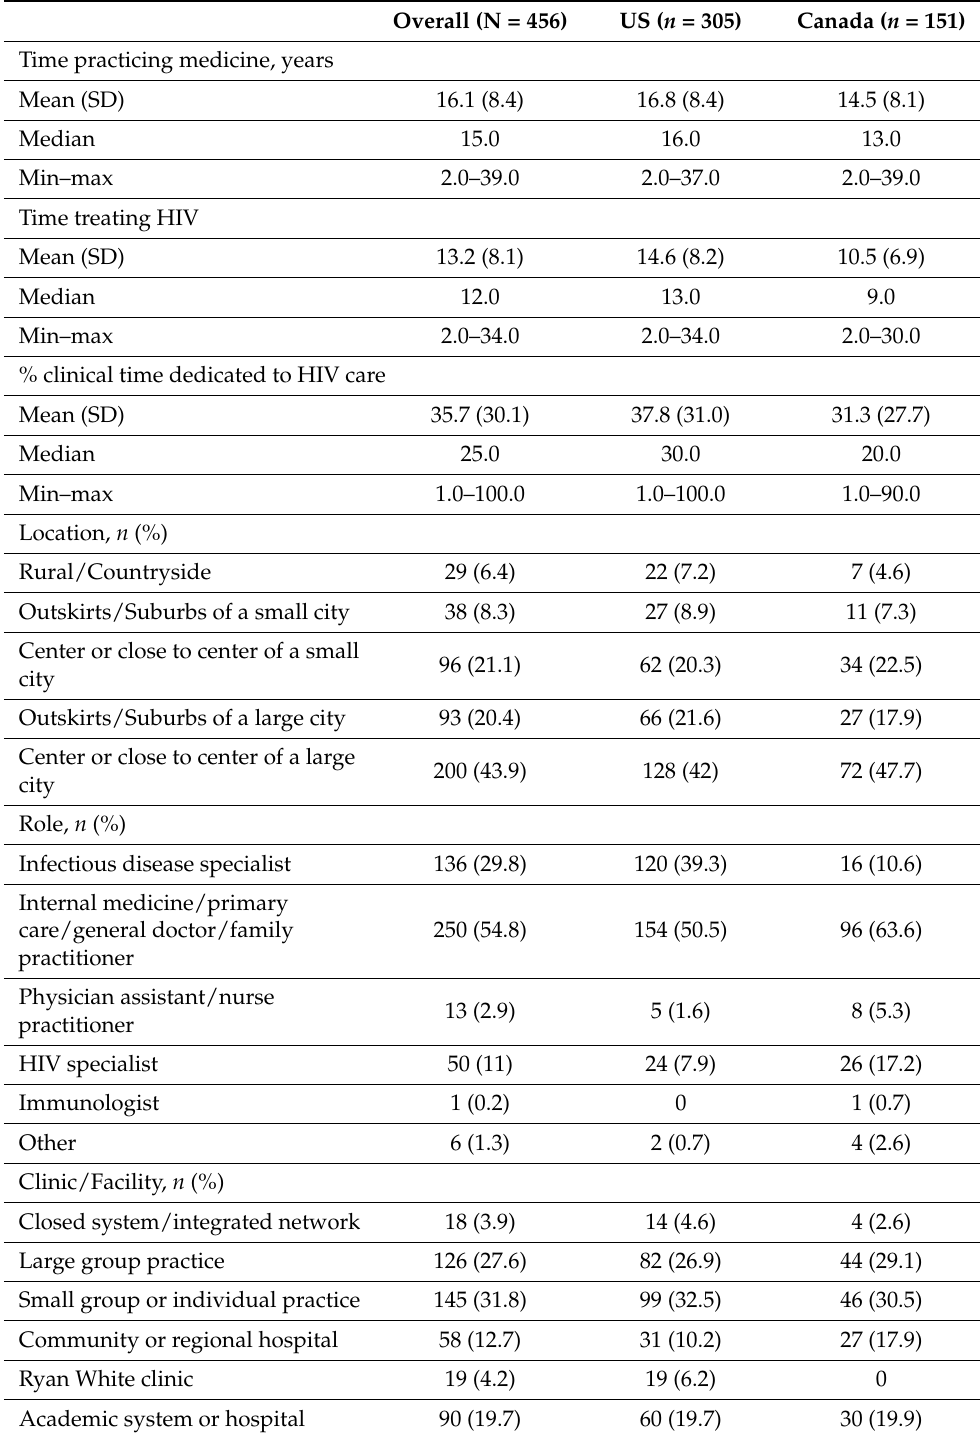
Table 4. Clinical experience of